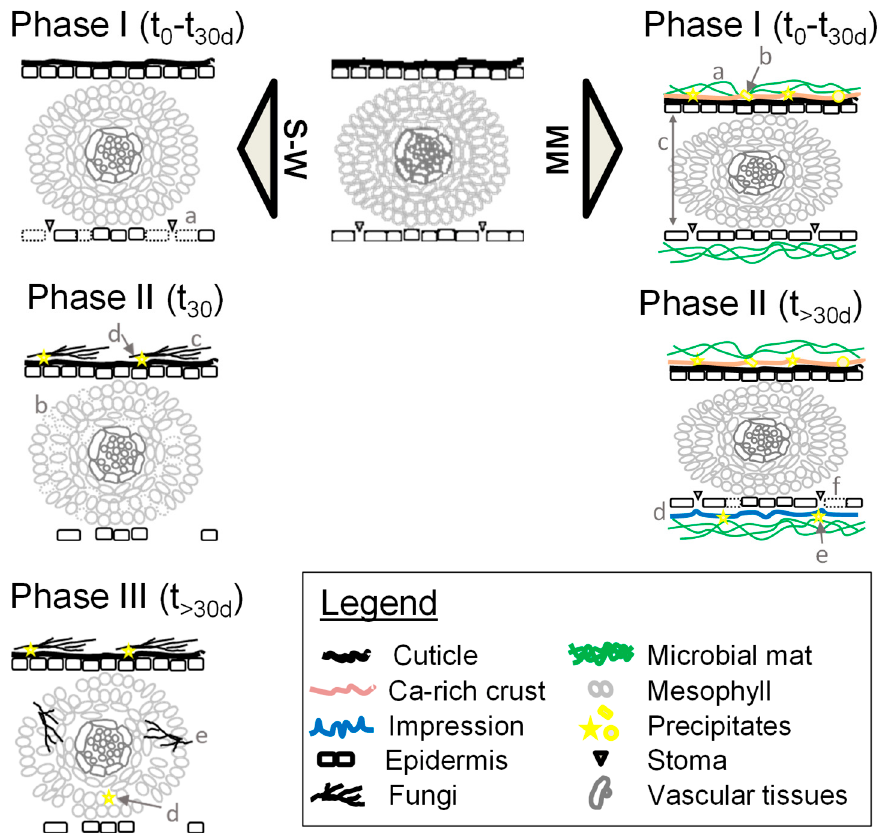
Figure 11. Schema of the taphonomic alterations observed in the control (sediment–water, S–W) and microbial mat (MM) tanks. S–W alterations observed at the sediment–water interface (control tanks). Phase (1): a, breakage of lower epidermis cells with stoma. Phase (2): b, fungal external invasion; c, mesophyll cell disorganization and deformation; d, mineral precipitation. Phase (3): e, fungal inner invasion at the endodermis; f, mineral precipitation in the inner tissues. MM, alterations observed in subaqueous conditions with microbial mats. Phase (1): a, mesophyll compression; b, mat coverage of the rest and early precipitation of a veil enriched in calcium; c, early mineral precipitation in the upper epidermis. Phase (2): d, generation of pinnule impressions; e, mineral precipitation at the lower epidermis; f, breakage of lower epidermis cells with stoma.